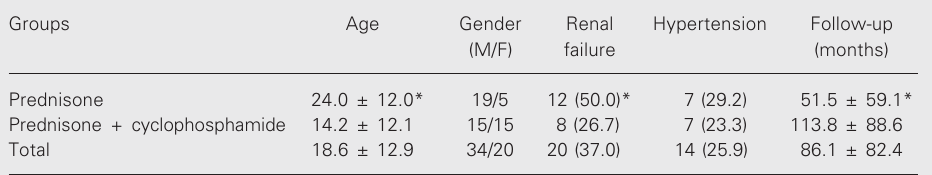
Table 1. Demographic data and clinical findings at the time of initial evaluation for patients with nephrotic syndrome in the two treatment groups. Groups